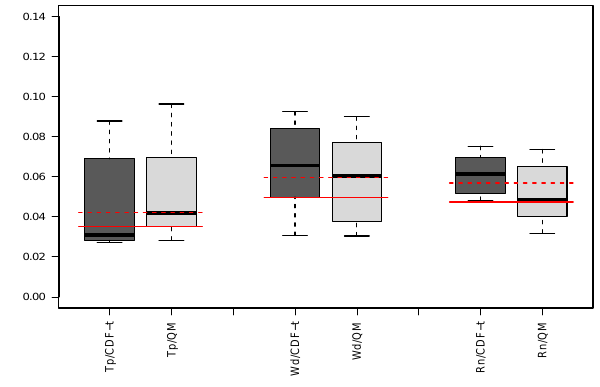
Fig. 5. Boxplots from the eight stations of KS scores computed be- tween the CDF of the observations from the validation/projection period and the ERA40-downscaled CDFs, from both CDF-t and QM, for temperature (Tp; two left-hand side boxplots), wind speed (Wd; two middle boxplots) and rainfall (Rn; two right-hand side boxplots) in